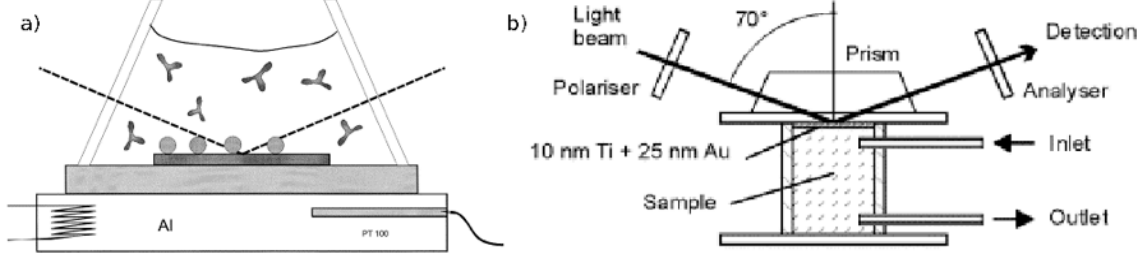
Figure 9. Set-up of the ellipsometry (ELM) ( a ) and the surface plasmon enhanced ELM ( b ). Reproduced from [81,82] with permission from